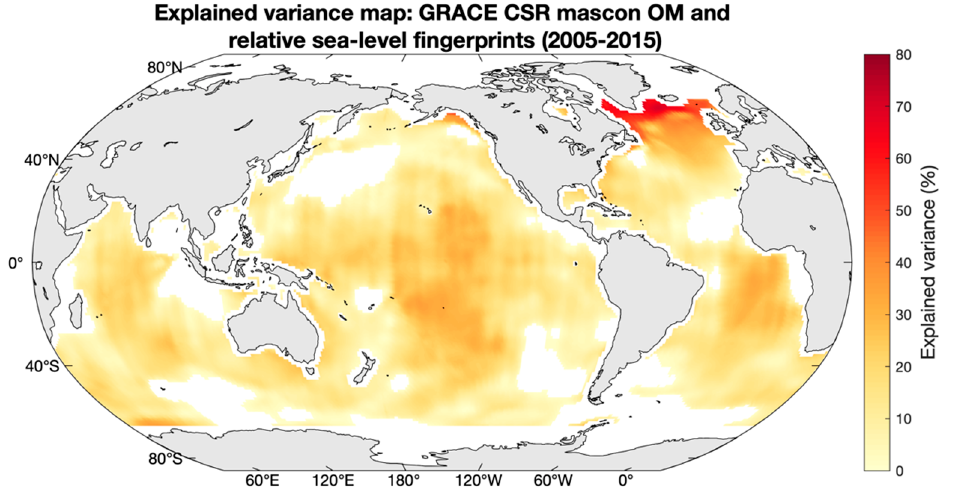
Figure 11. Explained variance map between GRACE ocean mass (OM) and relative sea-level finger- prints time series for January 2005–December 2015.